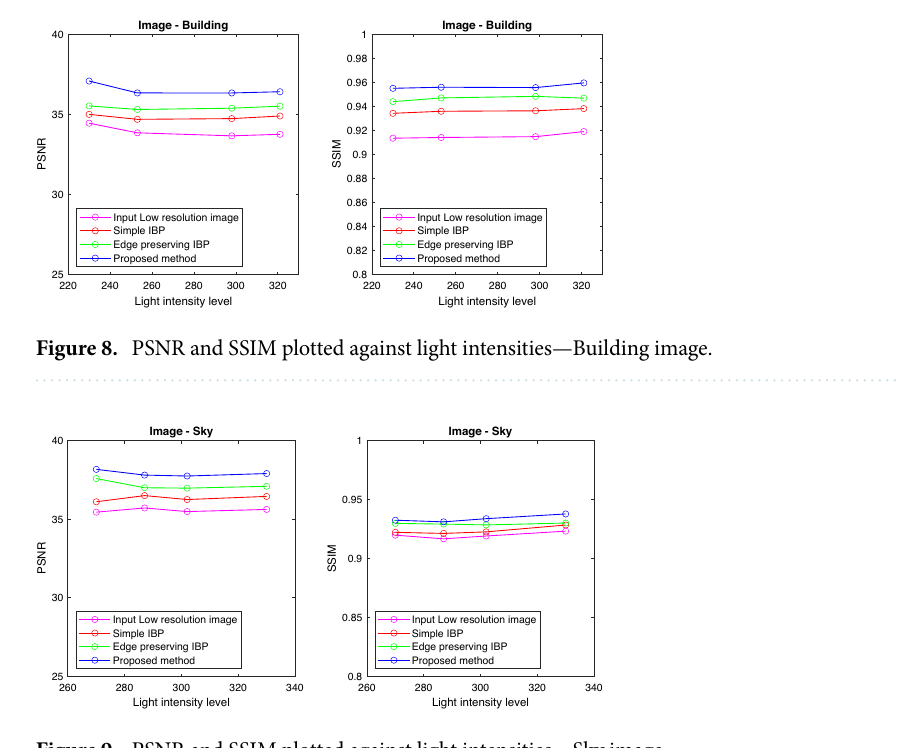
Figure 9. PSNR and SSIM plotted against light intensities—Sky image.